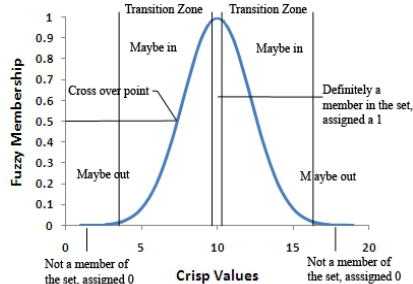
Fig 4: Fuzzy membership function diagram (Dombi,